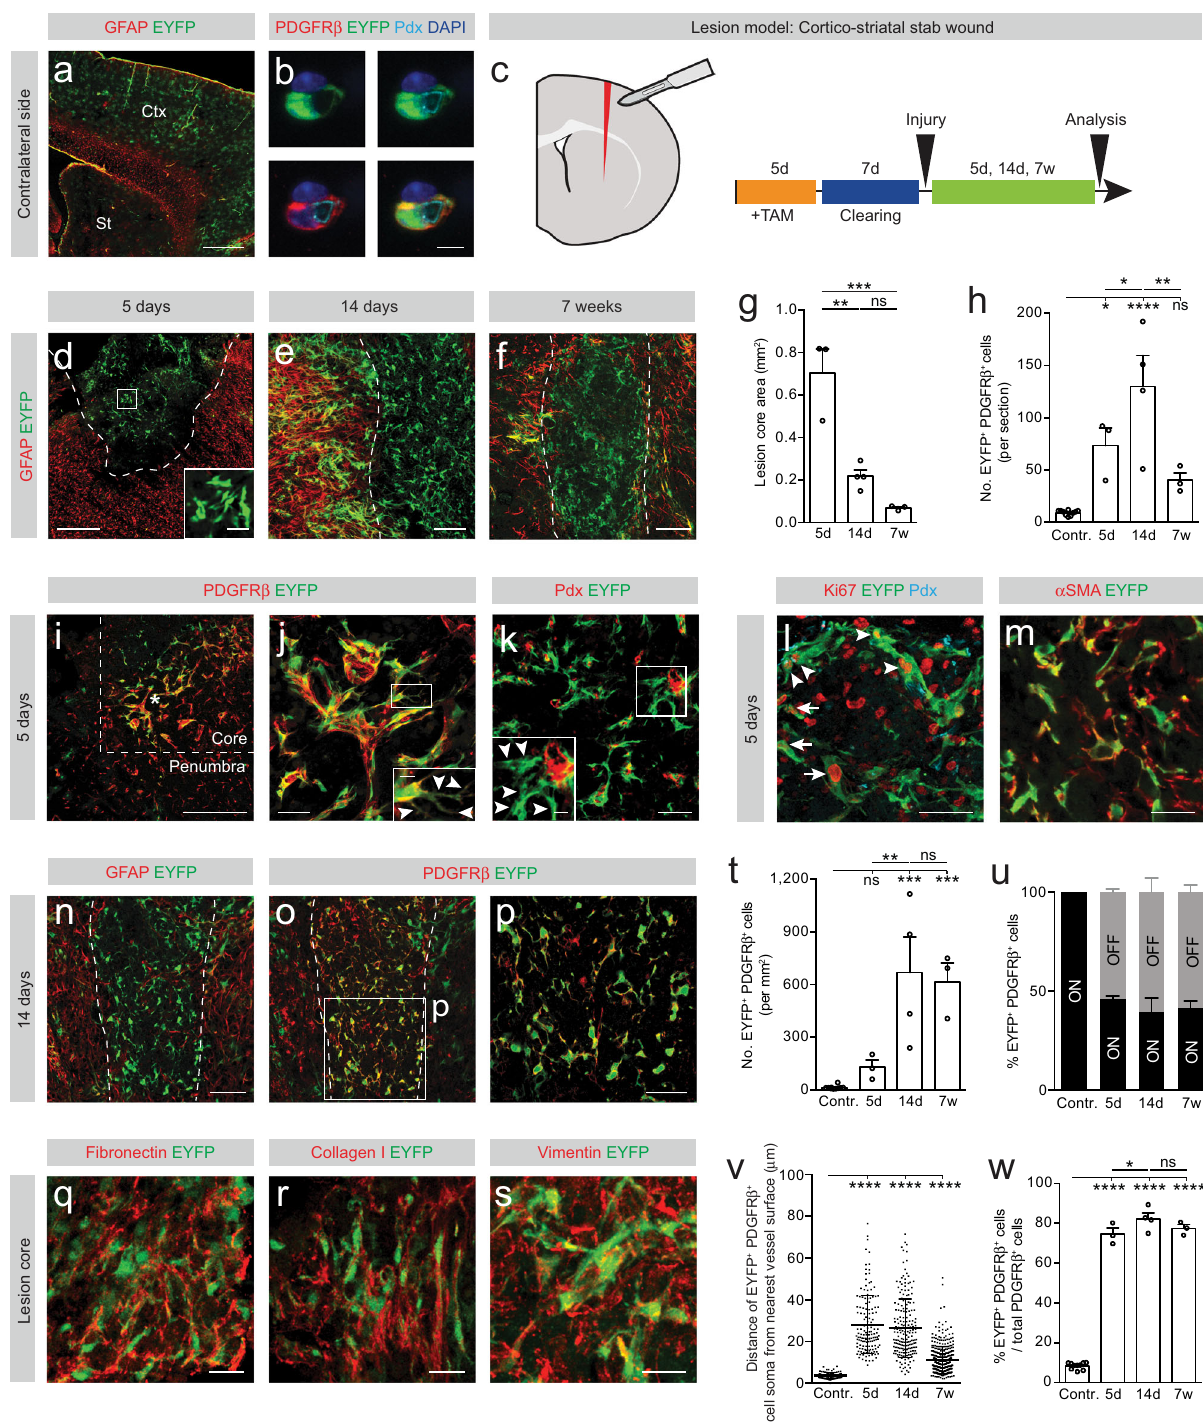
model as large cortical stab wound (Fig. 3a). As opposed to small cortical lesions (Supplementary Fig. 9), large cortical stab wounds triggered widespread glial and fi brotic scarring and enabled us to examine the behavior and contribution of type A pericytes to fi brotic scarring in the cerebral cortex (Fig. 3b – e). At 5 dpi we found that type A pericytes and progeny co- expressed Tbx18 and the stromal marker PDGFR β and fi lled up the fi brotic lesion core, immediately fl anked by the glial scar (Fig. 3b, d, f – h, Supplementary Fig. 10). Many recombined cells